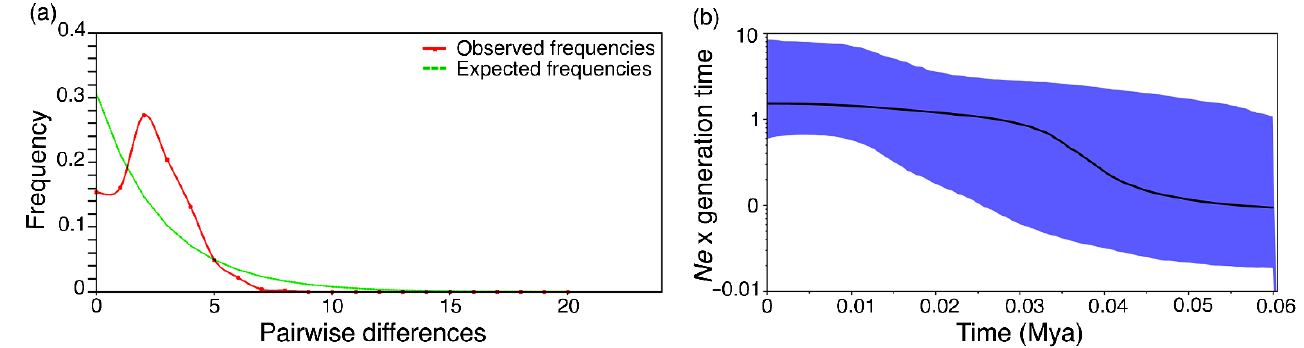
Figure 5. Estimated population demographic changes of mitochondrial haplotypes obtained from 95 individuals of Steindachneridion melanodermatum in the Lower Iguaçu River. ( a ) Demographic history depicted by Pairwise mismatch distributions. Pairwise differences (X-axis) are shown against frequency (Y-axis). ( b ) Bayesian skyline plot (BSP) shows the fluctuations over time in the effective population size. The black line represents the median, and the blue area indicates 95% of the estimates’ HPDs (highest posterior densities). The X-axis represents time in millions of years (mya), and the Y-axis is the inference of changes in effective population size per generation over